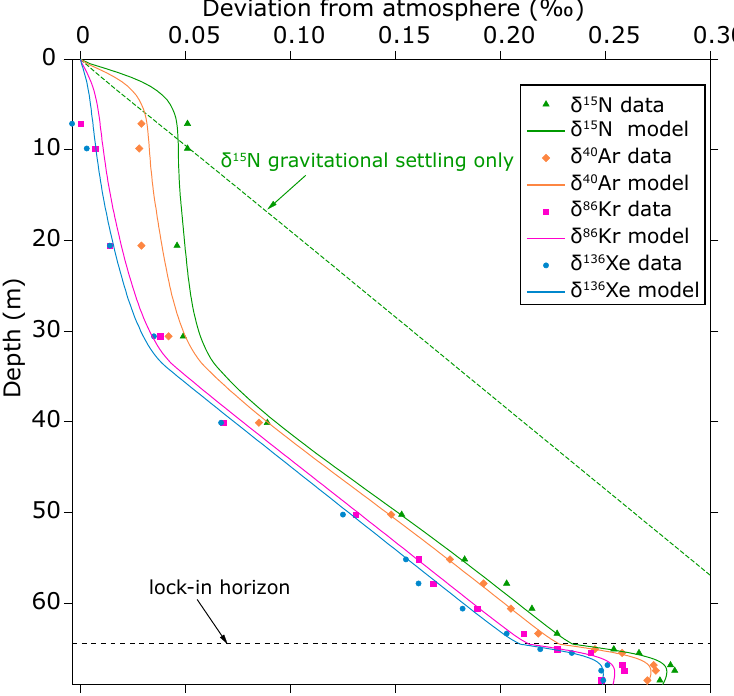
Fig. 3. Observed inert gas ratios in firn air at the Megadunes site, East Antarctica, January 2004. Values are averaged for each depth where replicate measurements are made. To facilitate comparison, δ values are normalized by dividing by the mass difference. The lock-in horizon depth of 64.5m is found from measured CO 2 and CH 4 data. Model results are for a surface eddy diffusivity of 1 . 6 × 10 − 4 m 2 s − 1 and scale depth H of 5.9m in deep part of lock-in zone, increasing in upper part of lock-in zone in order to fit the data. This implies a deepening of convection through time, modeled as starting in 1934 C.E. and reaching the full depth of H = 12.2m in 2004 C.E.